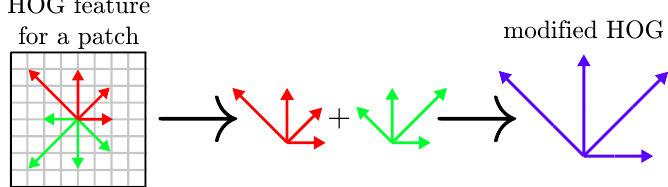
Figure 10. HOG feature to gradient reversals invariant HOG feature conversion: gradients with opposing direction are added. Descriptors are hence twice